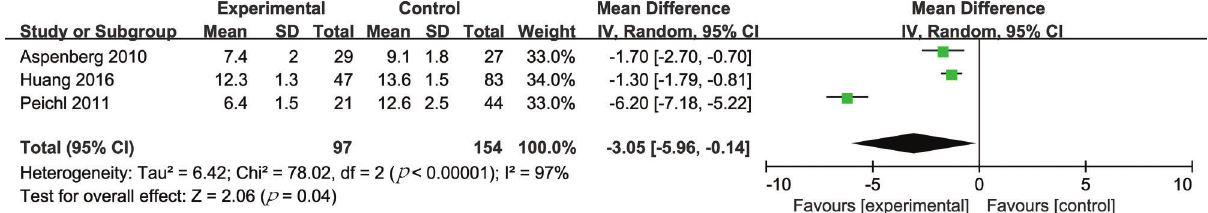
Figure 3 - Forest plot for radiological fracture healing time. Table 3 - Sensitivity analyses based on various exclusion criteria for fracture healing time. Excluded trial